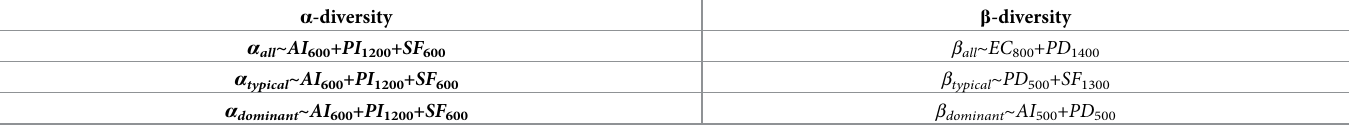
The landscape metrics are the aggregation index (AI), the edge contrast index (EC), patch isolation (PI), and the percentage of secondary forest (SF). The subscript numbers indicate the scale of effect (radius meters) of each landscape